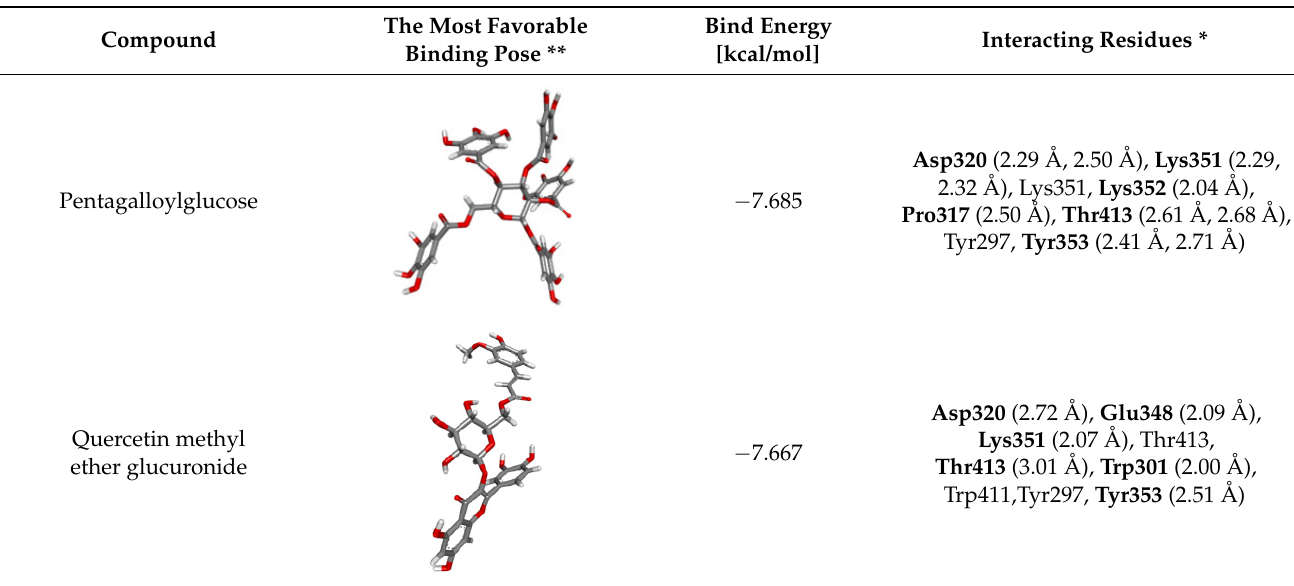
Table 3. Molecular docking simulation results of A. viridiflora constituents and positive control against NRP1 target (PDB ID: 2QQI).